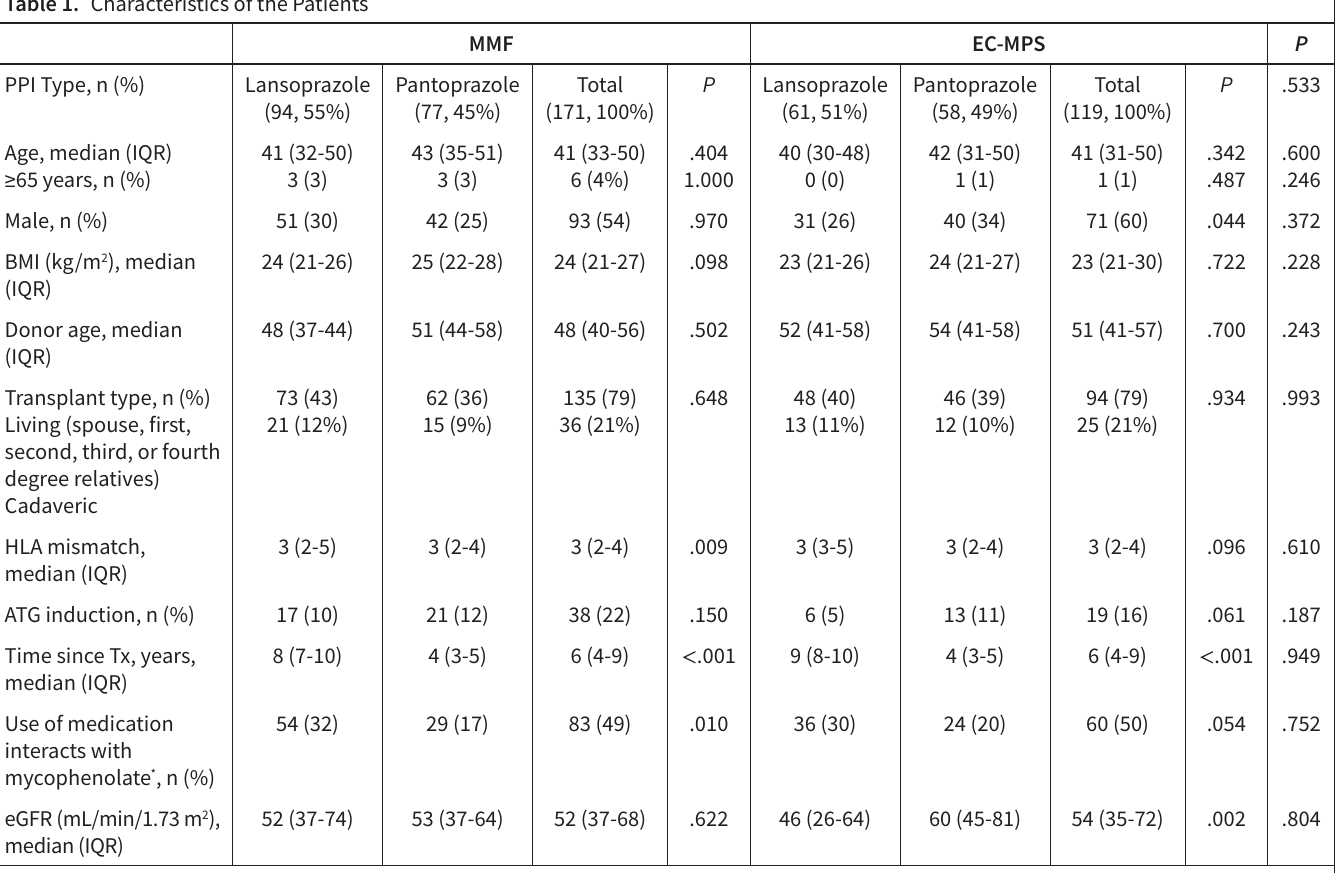
Table 1. Characteristics of the